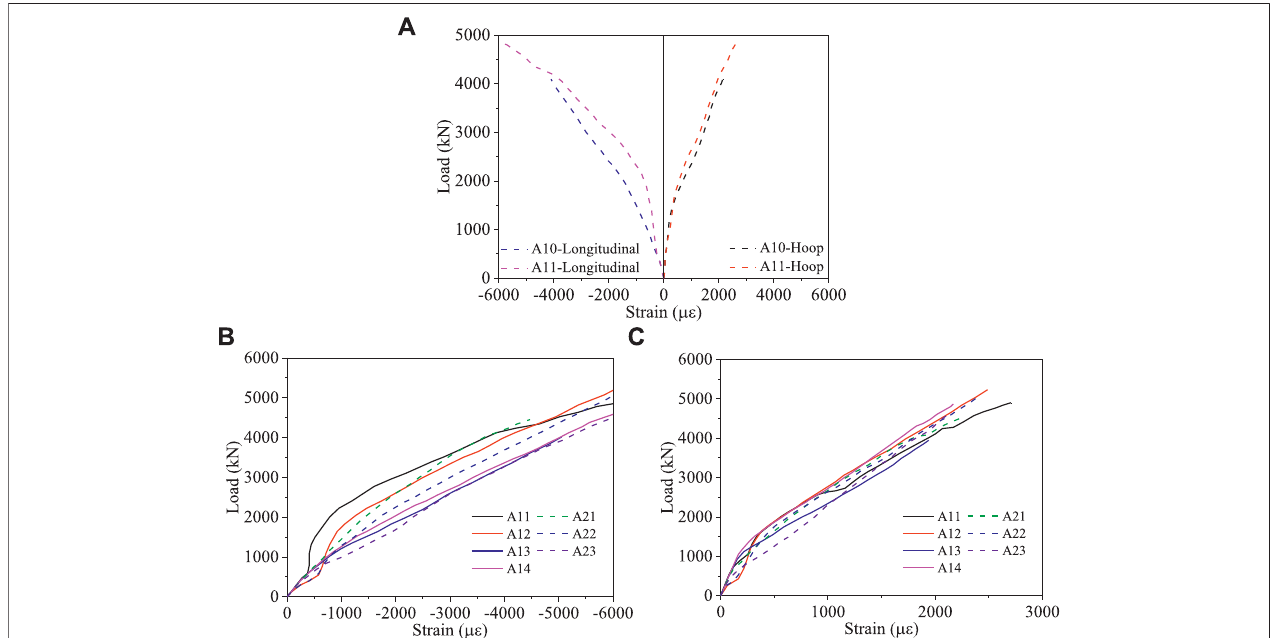
FIGURE6| LoadversusstraincurvesofspecimensA1~A14andA21~A23. (A) Load-straincurvesofspecimensA10andA11. (B) Load-longitudinalstraincurves. (C) Load-hoop strain curves.